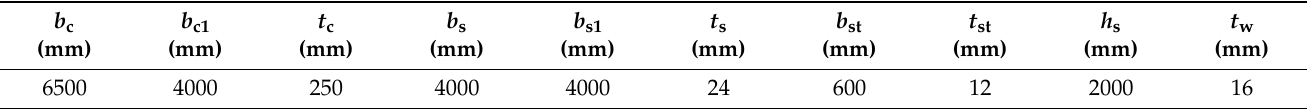
Table 3. Cross-section of the composite bridge